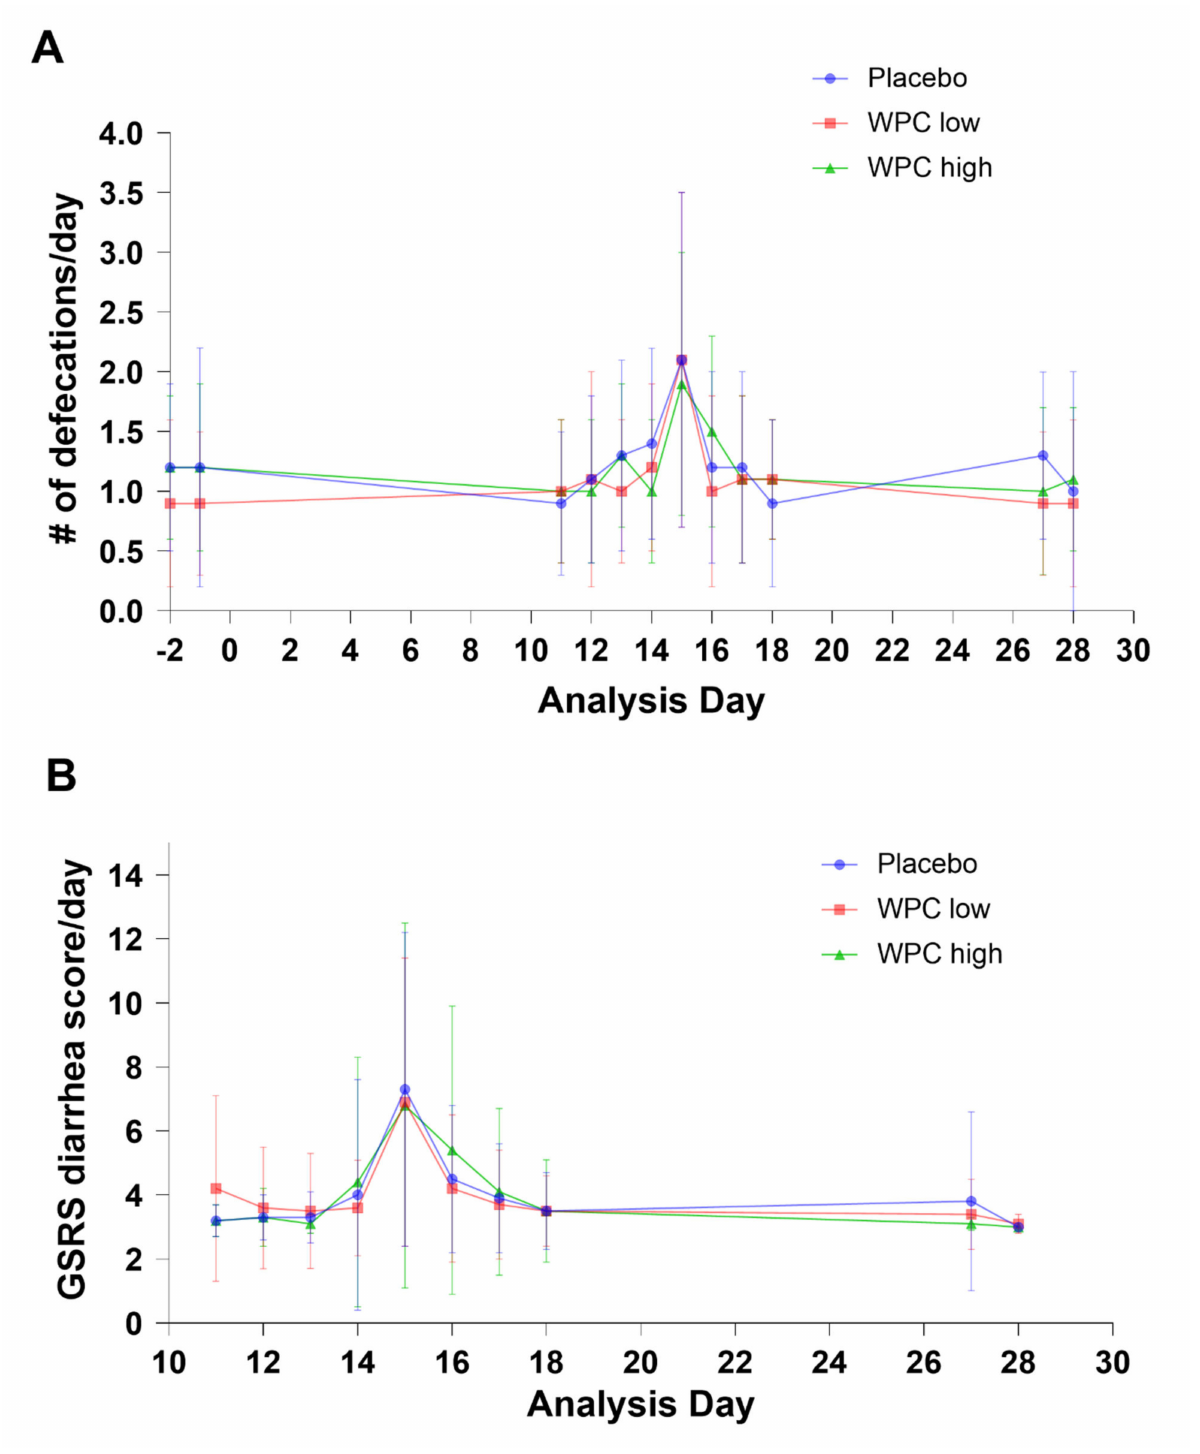
Figure 2. Response curves for stool frequency (mean # of defecations per day +/ − SD) ( A ) and GSRS (mean domain score diarrhea per day +/ − SD) ( B ) for the three treatment groups in the per protocol population. No statistically significant differences were found between placebo (circles, blue), WPC low (squares, red) and WPC high (triangles, green) using mixed model statistical